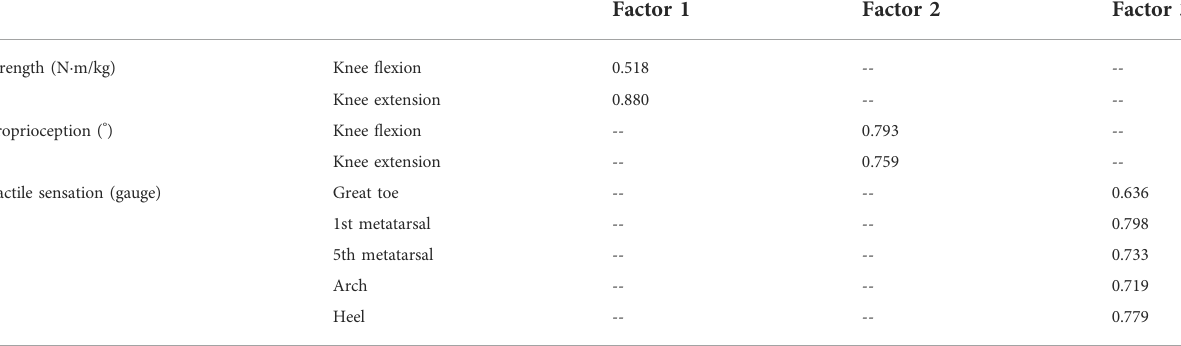
TABLE 3 Factor loadings for the variables among the categories of joint torque, proprioception, and tactile